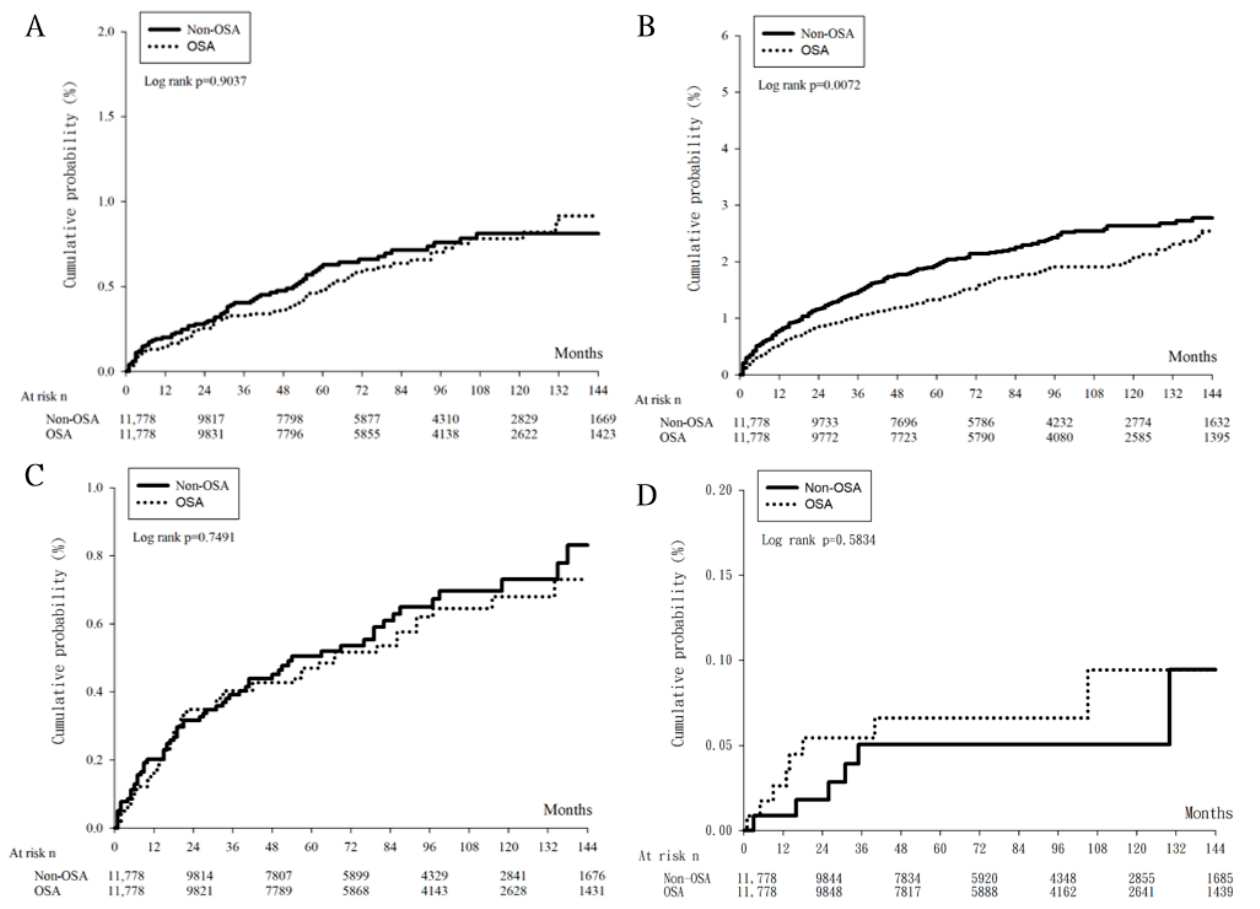
Figure 2. The cumulative probability of glaucoma management between obstructive sleep apnea group and control group. N: number, OSA: obstructive sleep apnea. ( A ) The cumulative probability of laser trabeculoplasty between the two groups, ( B ) The cumulative probability of trabeculectomy and tube shunt surgery between the two groups, ( C ) The cumulative probability of cyclodestructive procedure between the two groups, ( D ) The cumulative probability of eyeball removal between the two groups.